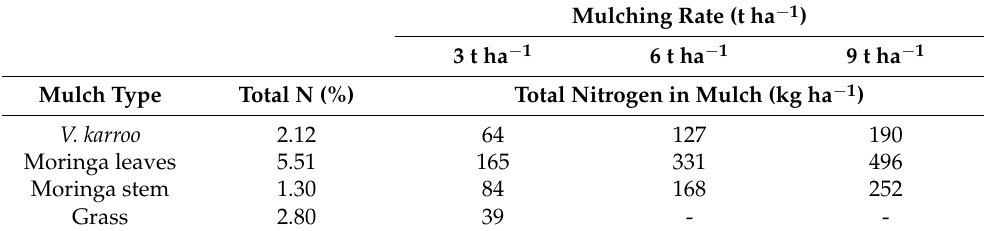
Table 4. Total nitrogen supplied in mulch at the three rates of